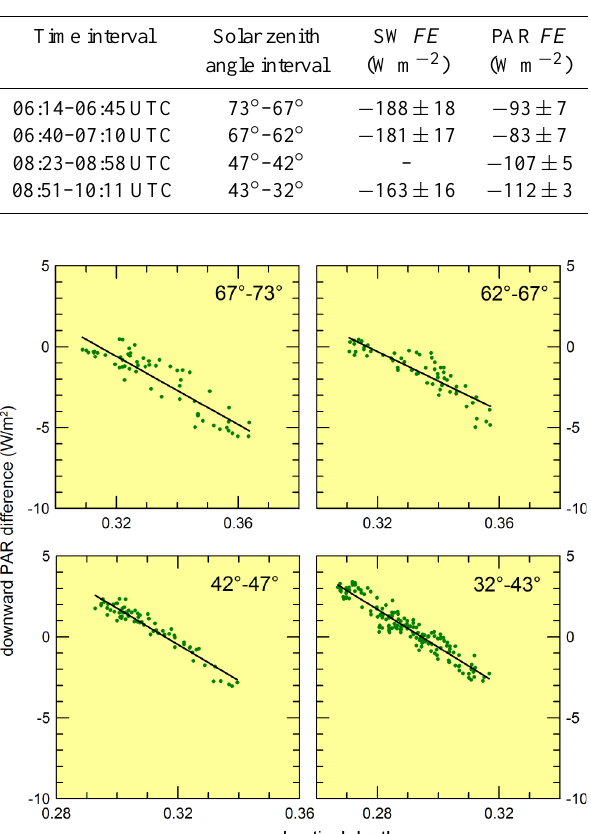
Table 1. Estimated dust forcing efficiencies derived in the short- wave and PAR spectral ranges and in different time/solar zenith an- gle intervals.